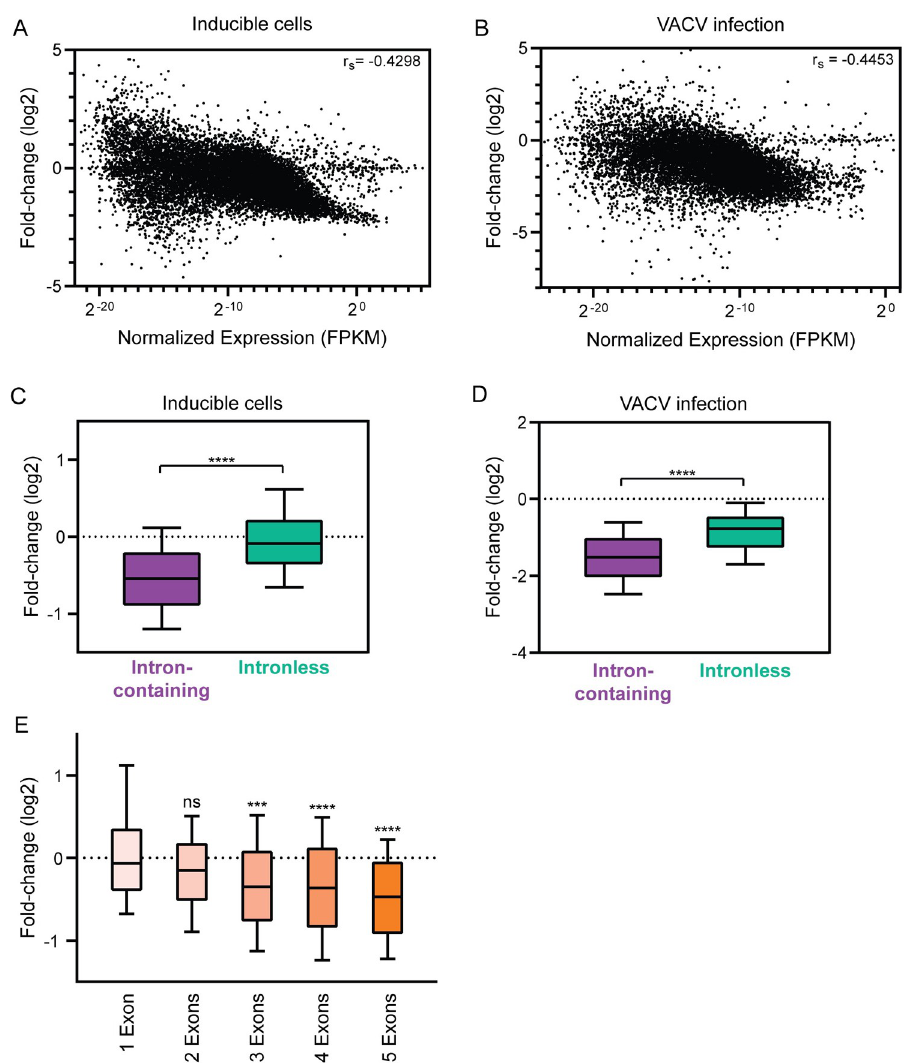
Fig 2. Intron-containing genes are more robustly downregulated by D10 than intronless genes. (A) The fold- change value upon WT D10 induction was correlated against the expression level of each host transcript. The Spearman correlation coefficient (r s ) is shown. Out of 17,704 data points, there are 108 data points outside the axis limits. (B) To isolate the contribution of D10 during infection, the fold-change value for each host transcript was calculated by dividing its expression in cells infected with Δ D9 VACV by its expression in D9muD10mu VACV at 18 hpi. These values were correlated against the expression level of each transcript. The Spearman correlation coefficient (r s ) is shown. Out of 14,630 data points, there are 201 data points outside the axis limits. (C-D) Cellular transcripts, excluding ncRNAs, within expression-matched dataset were divided into intron-containing or intronless category and plotted against their fold-change value reflecting D10 activity in dox-inducible cells ( C ) or during infection ( D ). ���� P � 0.0001, Mann-Whitney test. The whiskers represent the 10 th and 90 th percentiles. (E) Cellular transcripts within expression-matched dataset were binned according to the number of exons they contain and plotted against their fold- change value upon D10 induction. ns-not significant, ��� P � 0.001, ���� P � 0.0001, Kruskal-Wallis test followed by Dunn’s multiple comparison test versus “1 Exon”. The whiskers represent the 10 th and 90 th